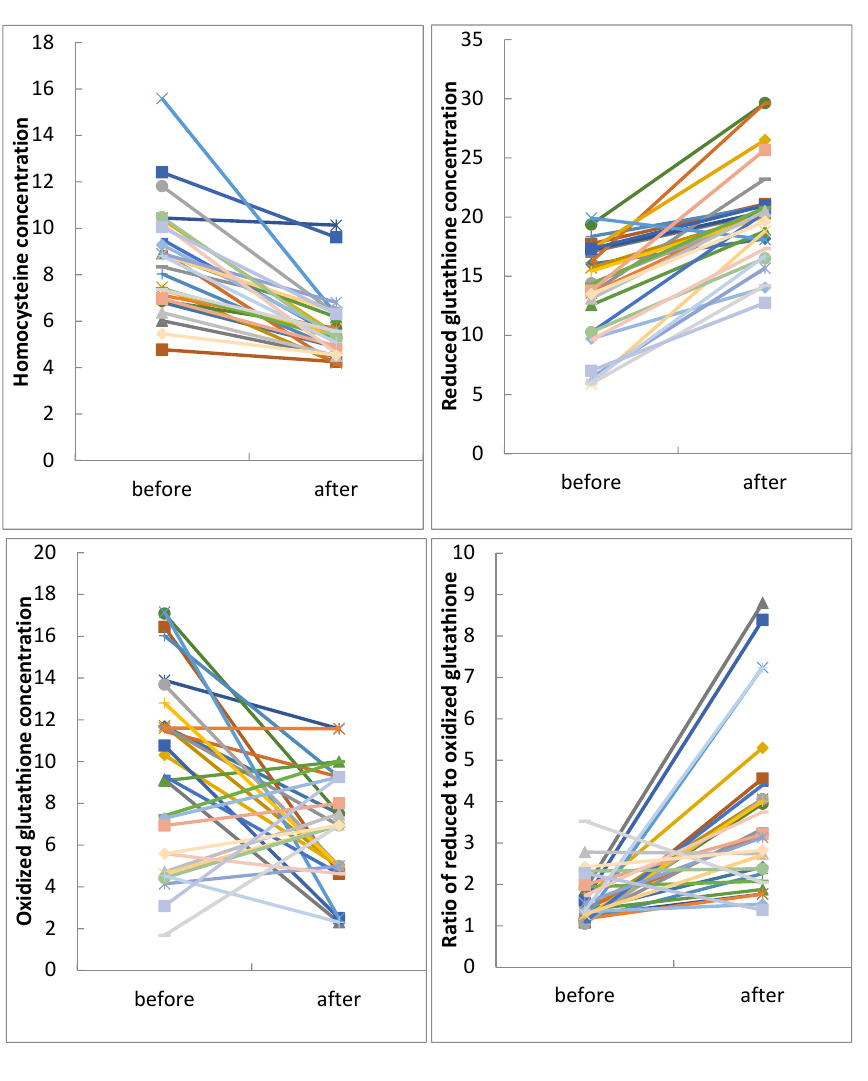
Figure 3. Scatter plots of individual data for plasma Hcy, tGSH, GSSG levels and tGSH/GSSG ratios from 29 autistic children before and after three months of folic acid treatment.